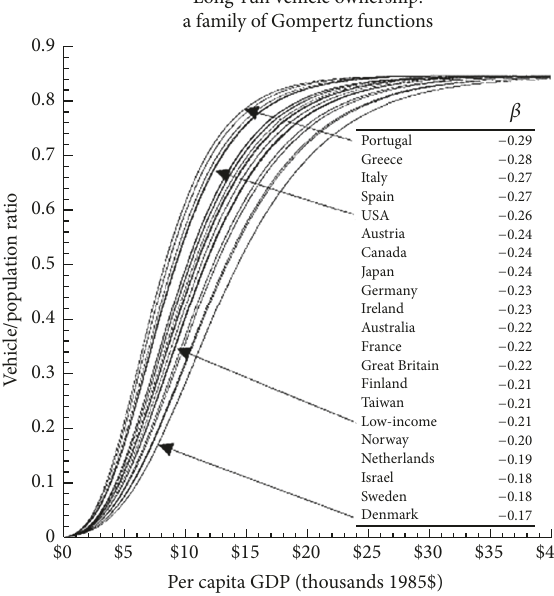
Figure 1: Projections of estimated vehicle Gompertz